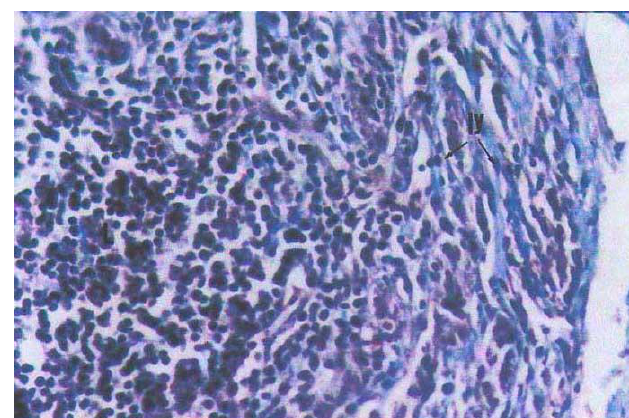
(Fig.22): Photomicroscopic illustrates epithelial cells